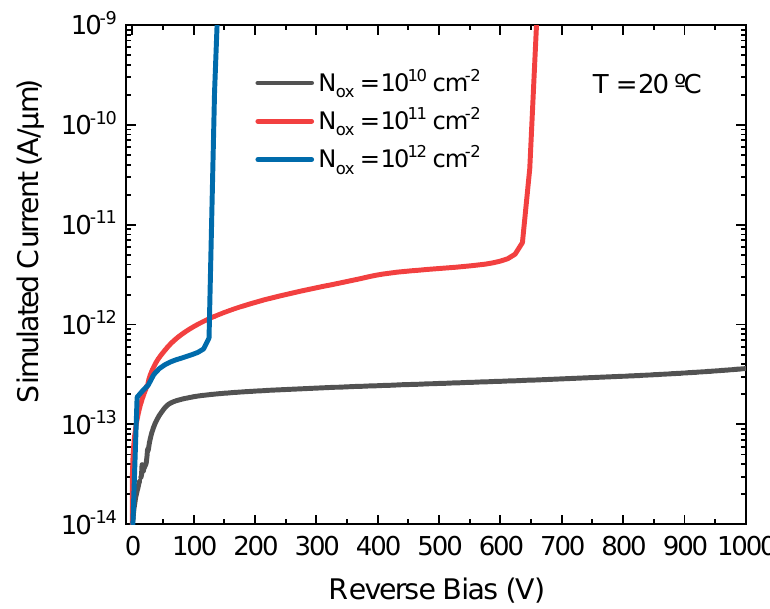
Figure 4. I-V simulation for an iLGAD with different N ox concentrations. Breakdown voltage is reduced by increasing N ox .